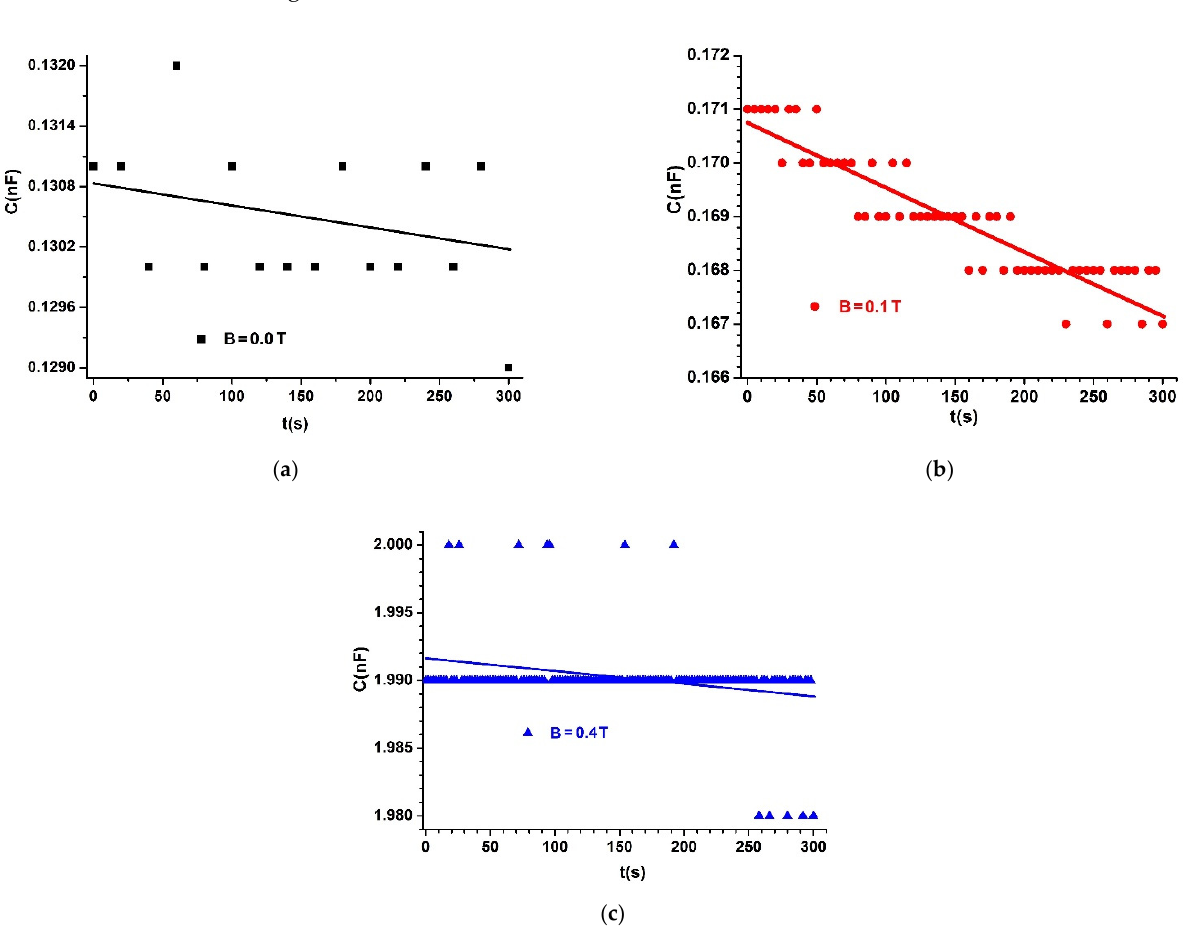
Figure 6. Electric capacitance of MC 1 capacitor placed in a magnetic field with magnetic flux density of: ( a ) B = 0.0 T; ( b ) B = 0.1 T; ( c ) B = 0.4 T. Dots are experimental data, and lines indicate linear